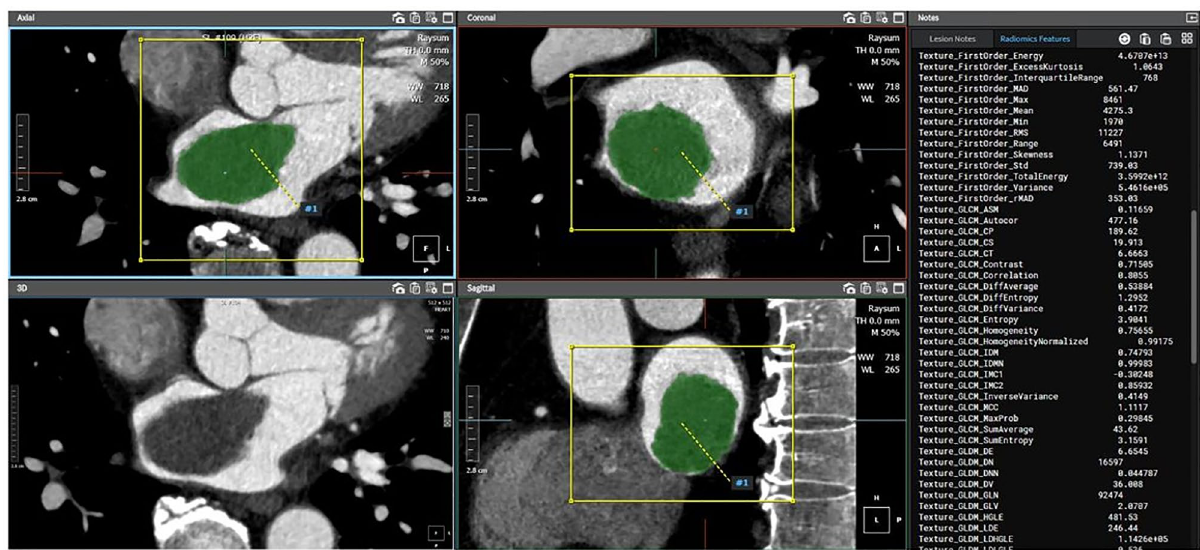
Figure 5. A 67-year-old man with cardiac thrombus in the left ventricle. A lobulated mass (25 mm) in the left ventricle. The predictive probability of tumor based on radiomics features of this mass was 0.237.